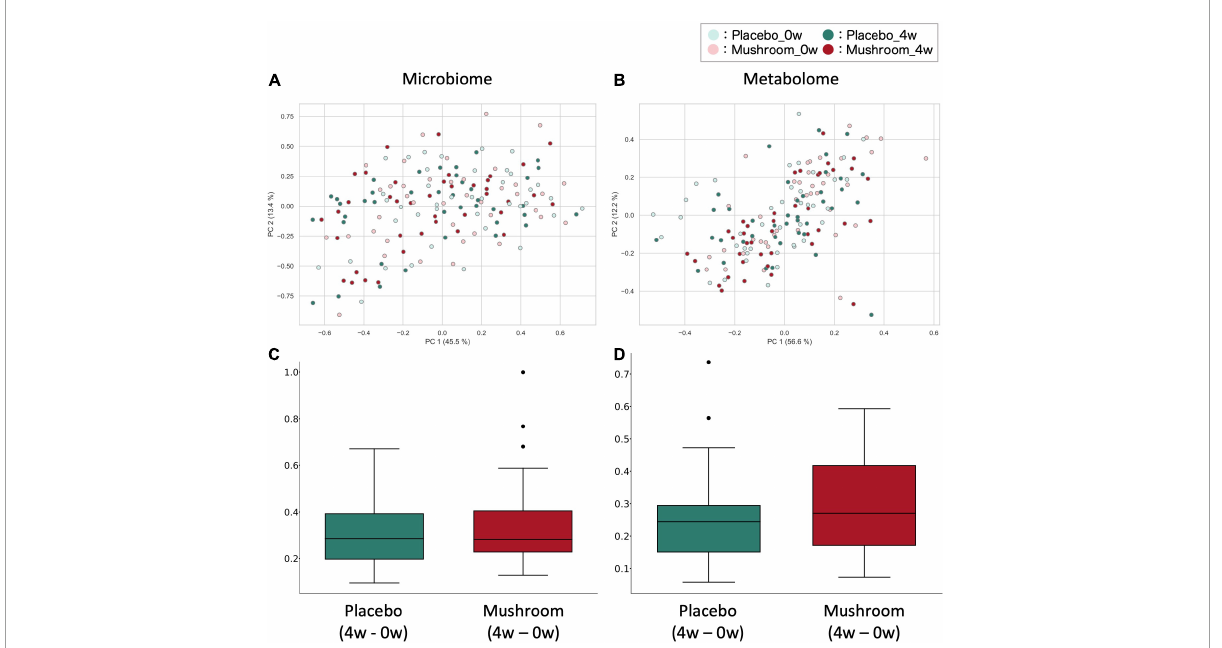
FIGURE2 Effect of mushroom consumption on gut microbiota and metabolome profiles. (A,B) The (A) weighted UniFrac distance for the gut microbiota and (B) Bray–Curtis distance for quantitative metabolome profiles among all samples were calculated and visualized by PcoA. (C,D) After calculating the (C) weighted UniFrac distance of the gut microbiota and (D) Bray–Curtis distance of the quantitative metabolome profiles among all samples, the differences in distances before and after ingestion of the same subjects were evaluated and are shown here for each group. No significant differences were detected in either case (Wilcoxon rank sum